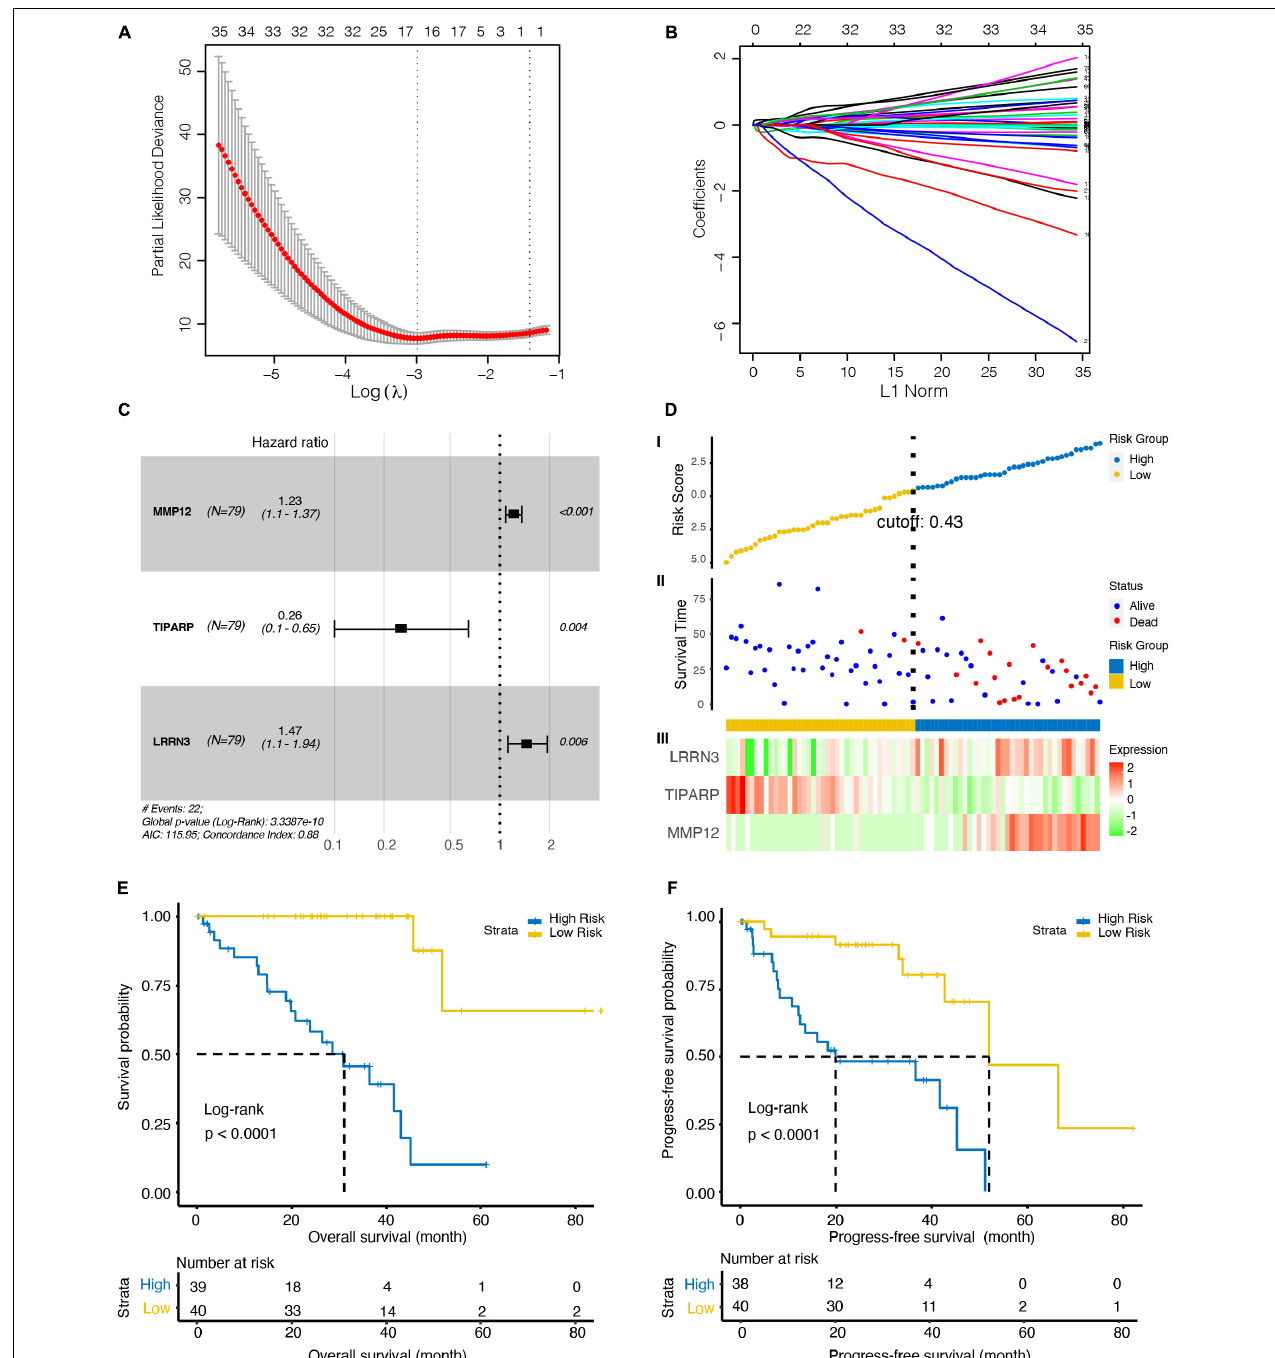
FIGURE 2 | Identification of an optimal marker model for prognostic prediction in the TCGA dataset UM patients. (A) 10-fold cross-validation for tuning parameter selection in the least absolute shrinkage and selection operator (LASSO) model. The first vertical line equals the minimum error (lambda = 0.05265), whereas the second vertical line shows the cross-validated error within one standard error of the minimum (lambda = 0.17646). (B) LASSO coefficient profiles of the fractions of 219 immune cell markers. Each curve corresponds to a variable. It shows the path of its coefficient against the L1-Norm of the whole coefficient vector as lambda varies. The axis above indicates the number of non-zero coefficients at the current lambda, which is the effective degrees of freedom (df) for the LASSO. (C) Forest plots showing associations between different immune cell markers and OS in the TCGA cohort. Unadjusted hazard ratios are shown with 95% confidence interval (CI). (D) Characteristics of the 3-gene pair prognostic signature. (top): the risk score of each UM patient; (middle): OS and survival status of UM patients; (bottom): heat map of gene expression profiles of UM patients in the TCGA cohort. (E) Kaplan–Meier curves for the OS of UM patients in high- and low-risk groups. (F) Kaplan–Meier curves for the progress-free survival (PFS) of UM patients in high- and low-risk groups.